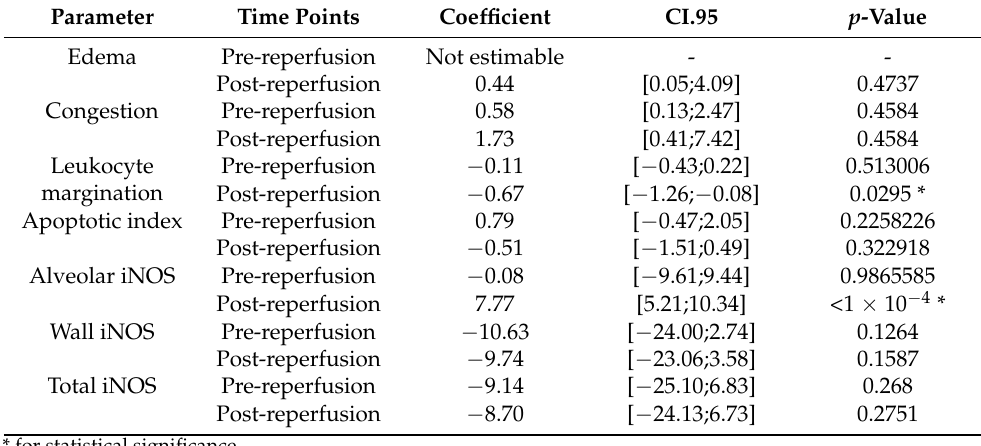
Table 5. Regression models at two time-points for each parameter in ECMO vs. non-ECMO patients.